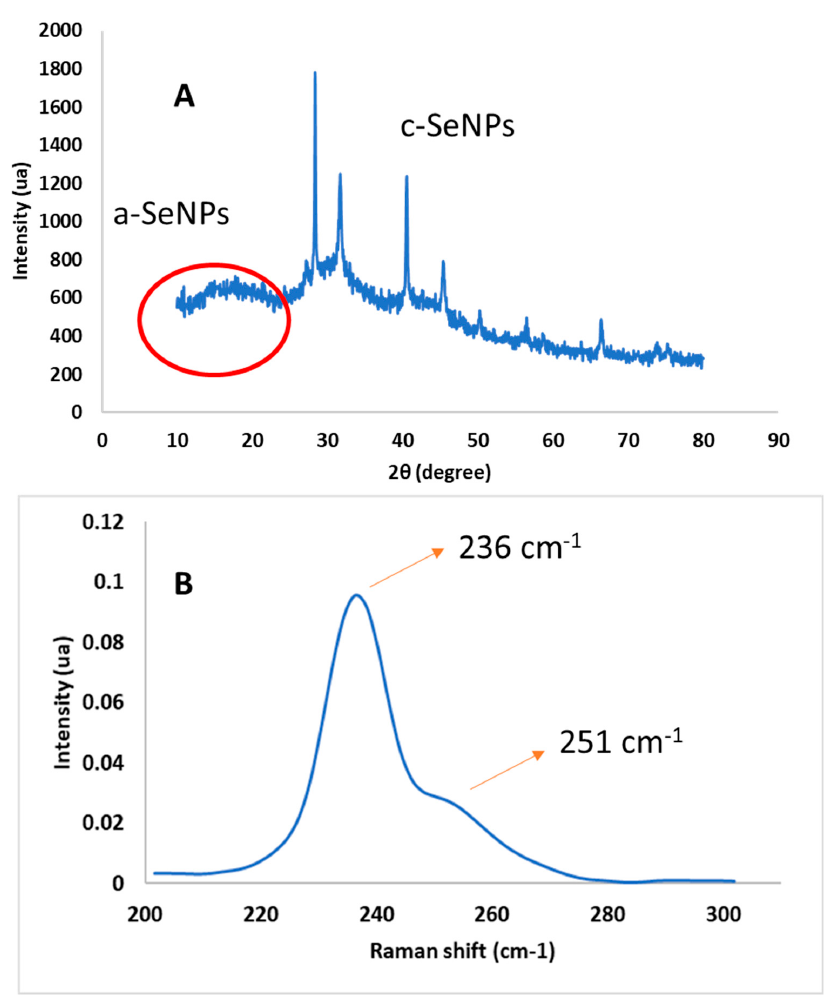
Figure 2. XRD pattern ( A ) and Raman spectrum ( B ) of SeNPs obtained under optimal conditions.